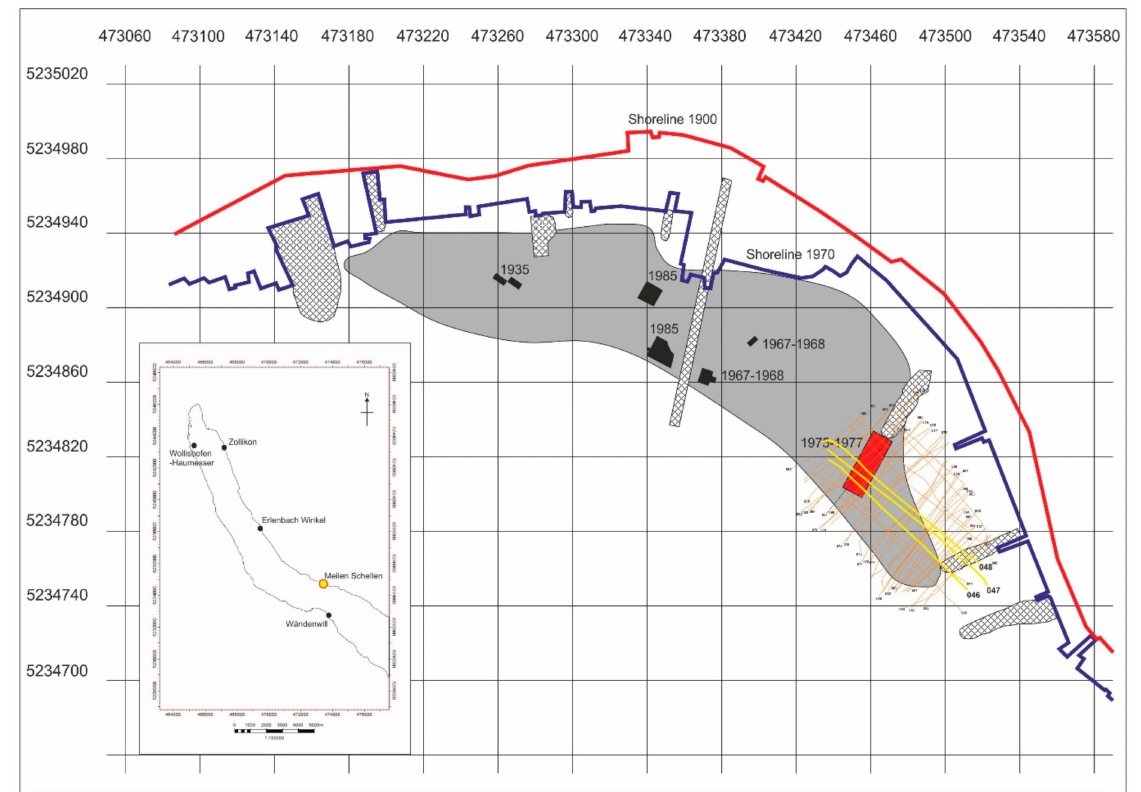
Figure 15. Meilen Schellen with its up to several metre-thick cultural deposits (grey area) comprising both Neolithic and Bronze Age horizons. The excavations are marked as black areas, apart from the 1975–1977 excavation in focus here, shown in red, where the cultural deposits are 1.2 m thick. Disturbances that have facilitated archaeological/stratigraphic observations through time are crosshatched. The sailing lines from 2019 are orange, with the lines 46–48 in yellow. UTM zone 32T coordinates. Based on Altorfer & Conscience 2005: 11–15. Graphic: